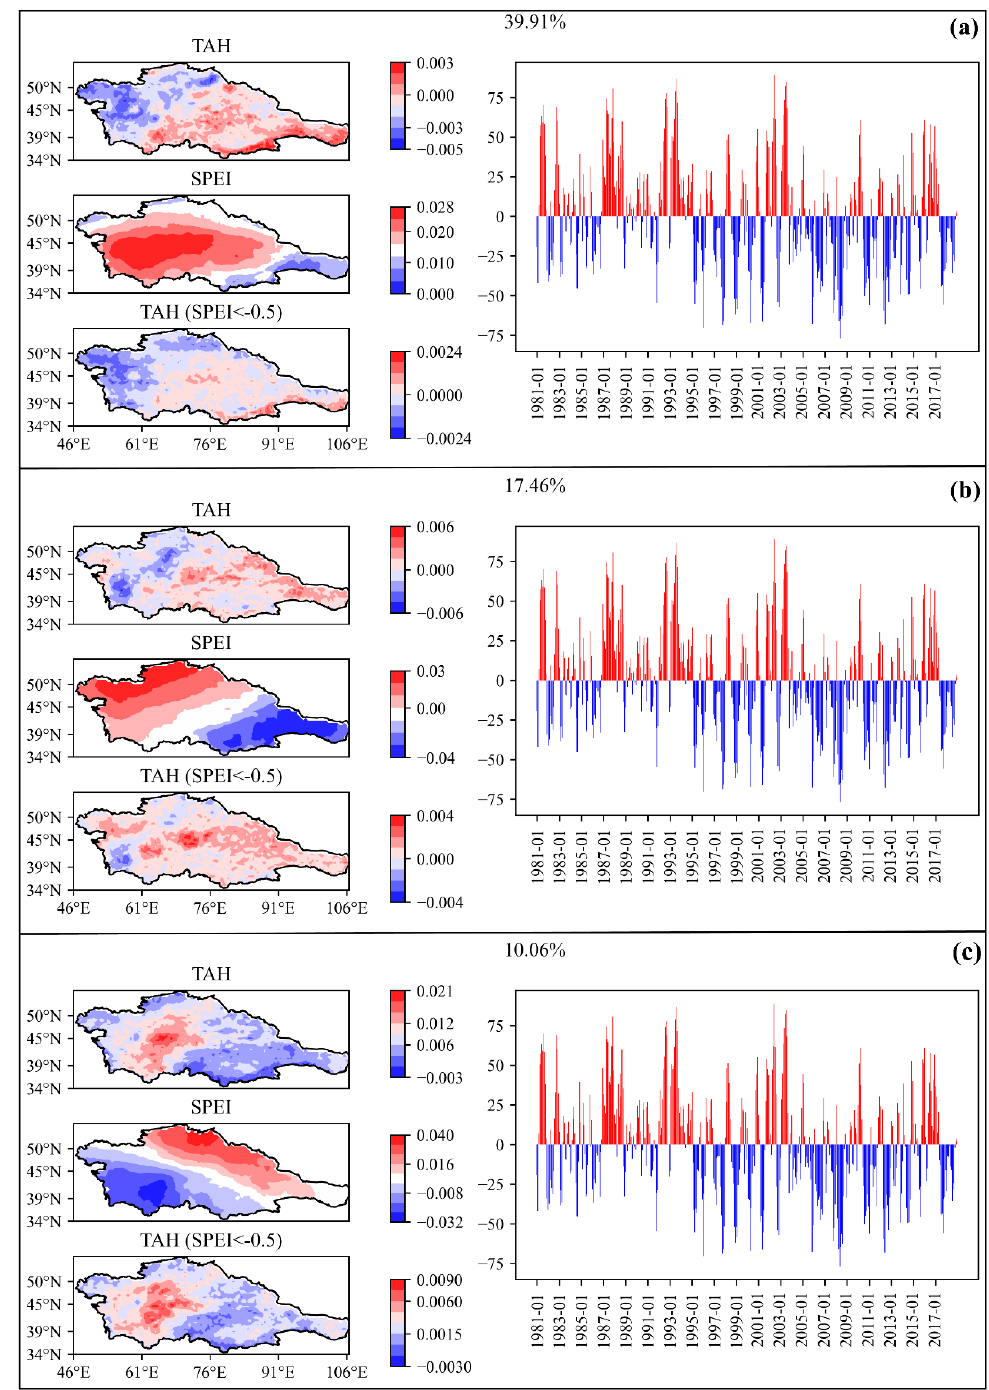
Figure 6. Multivariate EOF analysis of TAH (heatwave), SPEI (drought), and TAH(SPEI < − 0.5) (CDHWs). ( a ) First mode; ( b ) second mode; ( c ) third mode.